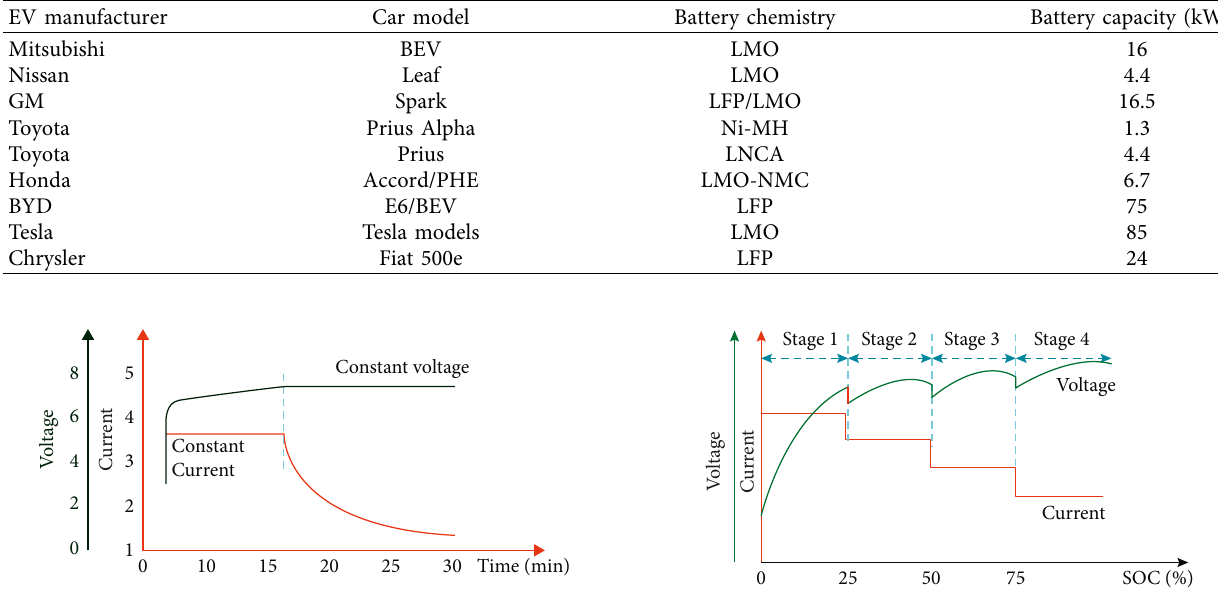
Figure 11: CC-CV charging.